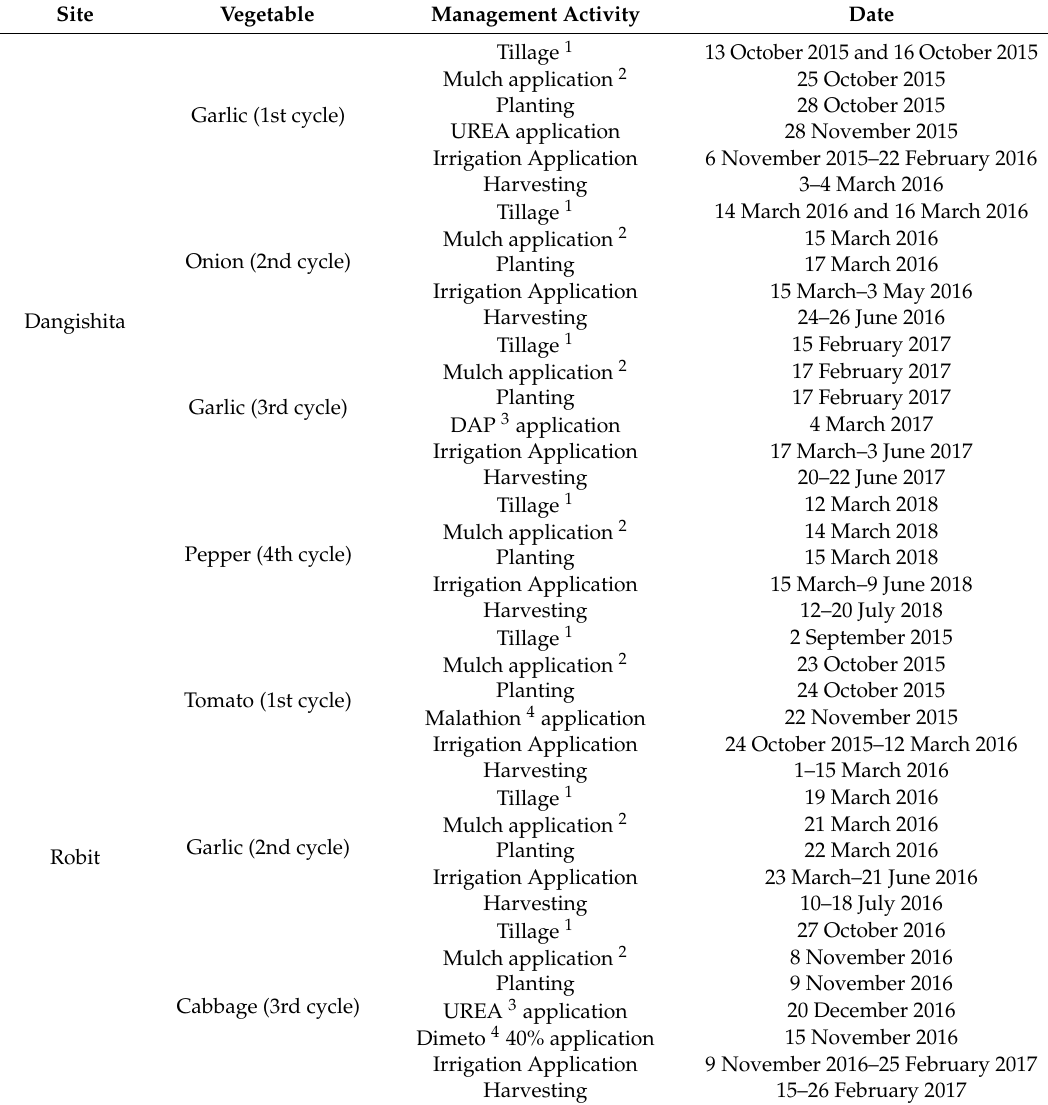
Table 1. Rotation of crops and management activities at Dangishta and Robit experimental watersheds adopted from Assefa et al.